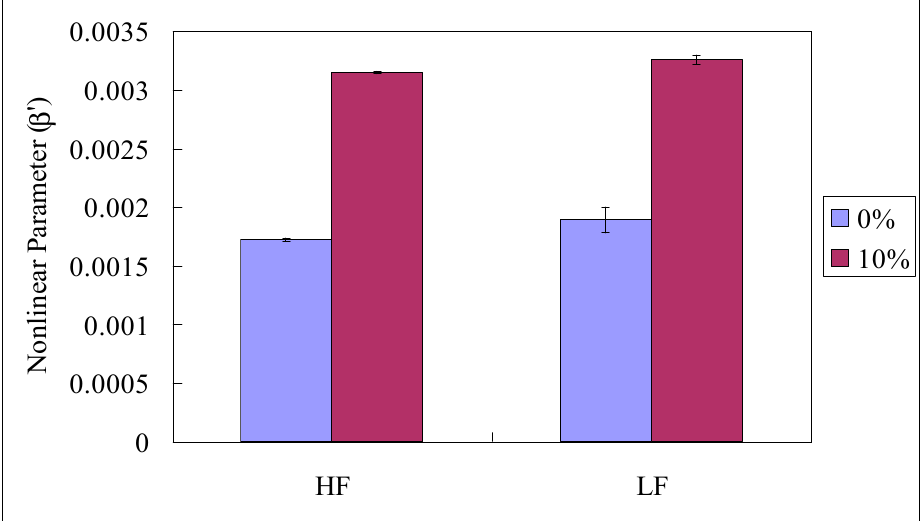
Figure 16. The nonlinear parameters with 10% deformation for HF and LF samples.